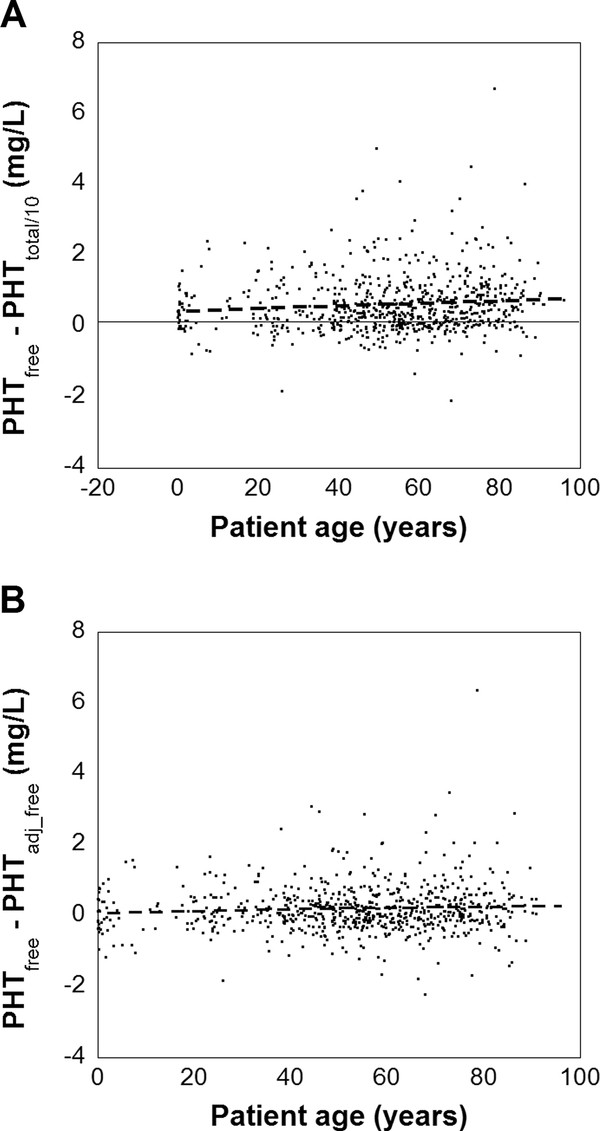
Variation of total phenytoin, adjusted phenytoin, and free phenytoin with respect to patient age. (A) Variation of the difference between PHTtotal/10 and PHTfree with respect to patient age. All data from chronologically first phenytoin measurements in 756 patients. The dashed line is from linear regression: [PHTtotal/10 - PHTfree] = -0.394 + 0.0038*(patient age) (R2 = 0.01). The 95% confidence intervals of the intercept is (-0.464, -0.372) and for the slope is (-0.056, 0.064). (B) Variation of the difference between PHTfree and PHTadj_free with respect to patient age is shown using same source of data as in (A). The dashed line is from linear regression: [PHTfree - PHTadj_free] = 0.0838 + 0.0021 * age (R2 = 0.004). The 95% confidence intervals of the intercept is (-0.0072, 0.174) and for the slope is (-0.053, 0.057)